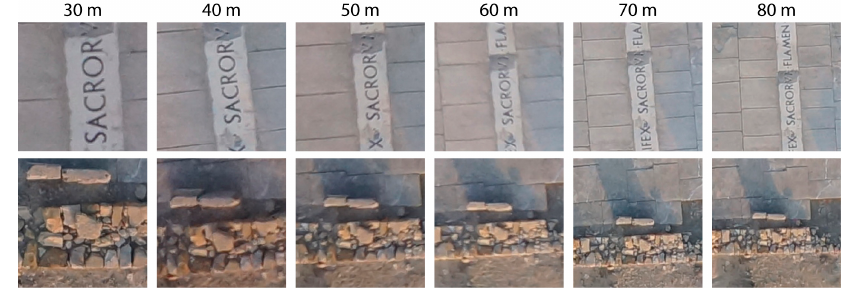
Figure 7. Effect of flight altitudes AGL on image coverage and quality.